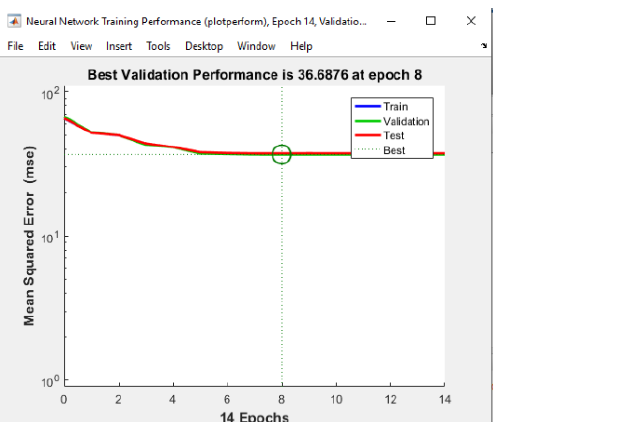
Figure 26 . shows the error histogram of the trained neural network for the training, validation and testing steps. This figure shows that the data fitting errors are distributed within a reasonably good range around zero.